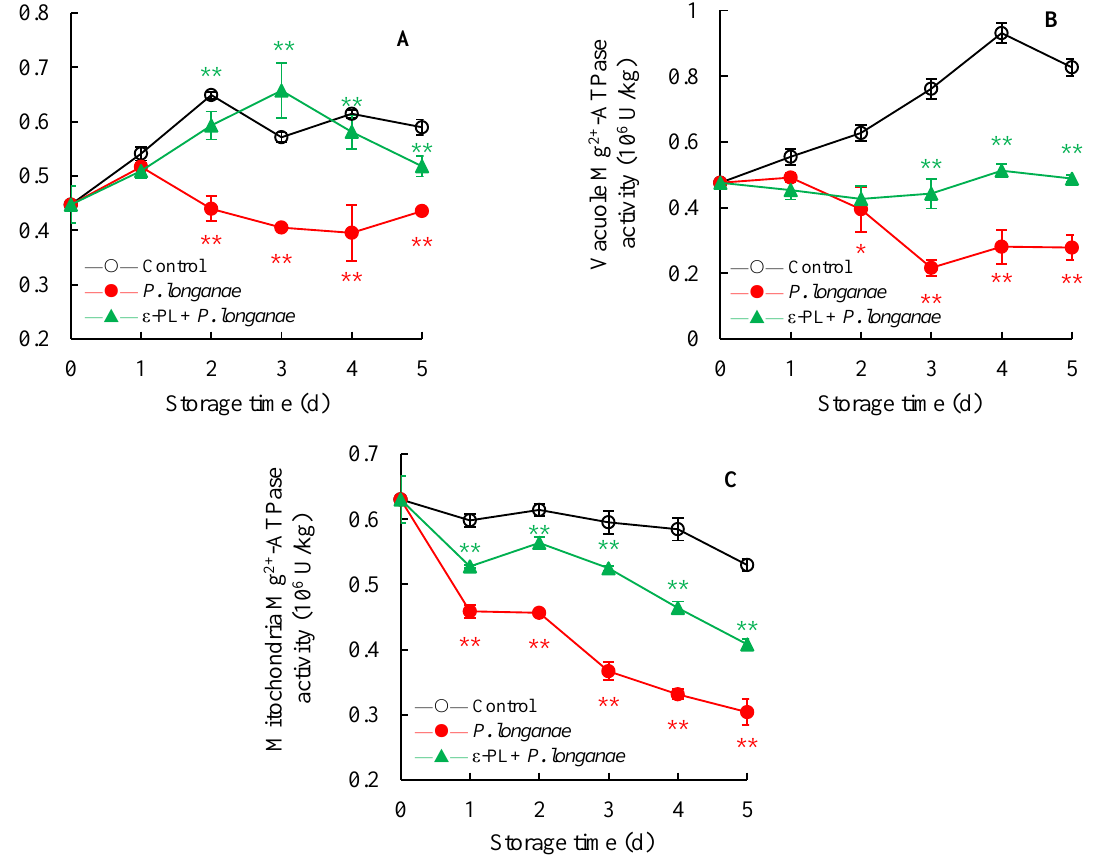
Figure 4. Effects of ε -PL treatment on activities of Mg 2+ -ATPase in membranes of protoplasm ( A ), vacuole ( B ), and mitochondria ( C ) in pericarp of P. longanae -inoculated longans. Value presented in figure equals mean ± standard error of triplicate analyses, vertical bars express the standard error of mean ( n = 3). The mark * or ** represents the significant difference ( p < 0.05 or p < 0.01) between the P. longanae -inoculated longans and the control longans on each storage day. The mark ** represents the significant difference ( p < 0.05 or p < 0.01) between the ε -PL-treated P. longanae -inoculated longans and the P. longanae -inoculated longans on each storage day. ○ , Control; ● , P. longanae ; ▲ , ε - PL + P. longanae .